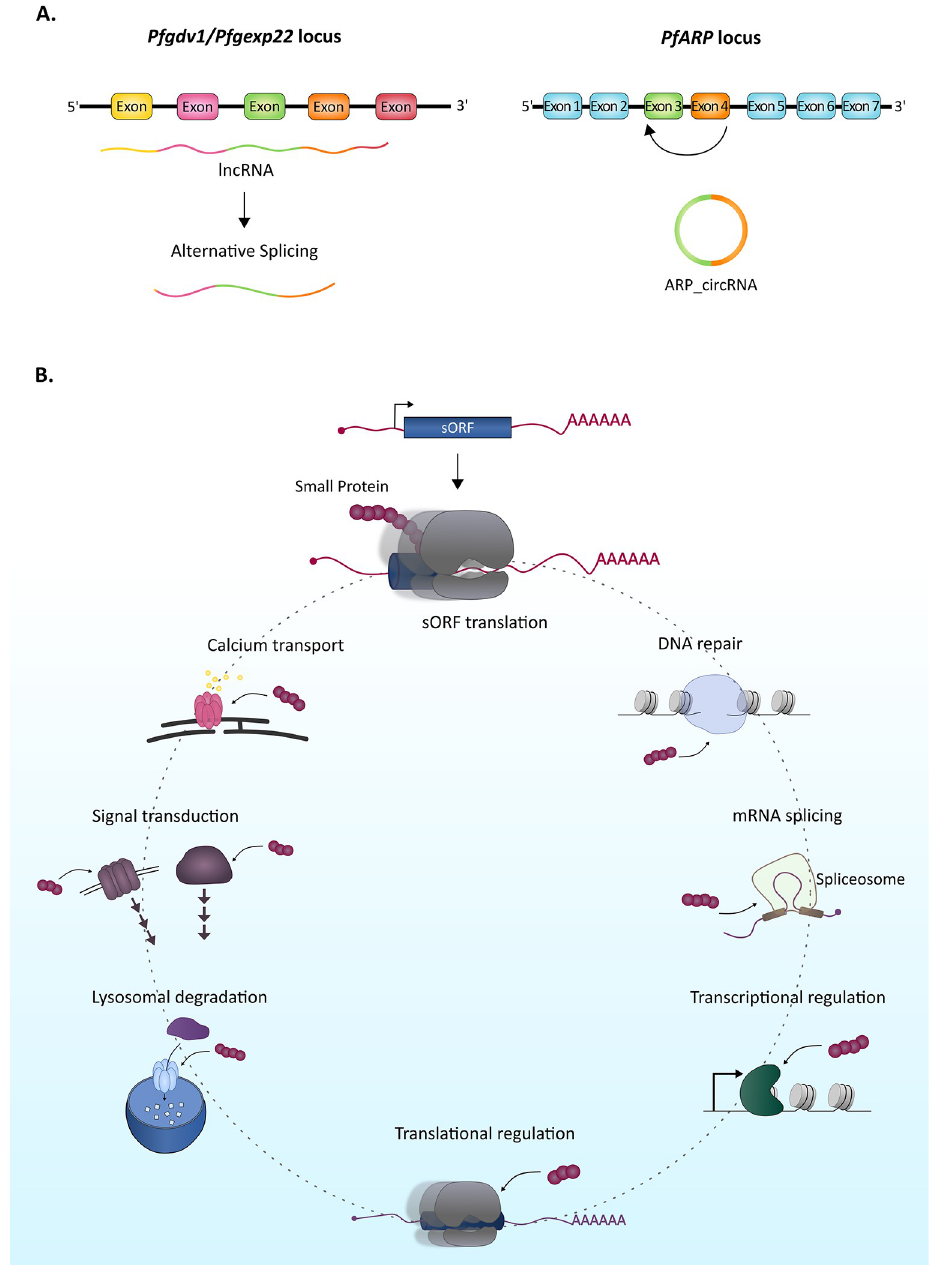
Fig 4. Splicing and translation of lncRNAs. (A) P . falciparum lncRNAs can undergo AS (left panel) and generate circRNAs as demonstrated for ARP_circRNA (apoptosis related protein circRNA) (right panel). (B) Some lncRNAs contain sORFs that are translated into small proteins with different biological roles, such as transcriptional and translational regulation, mRNA splicing, signal transduction, mitochondrial regulation, calcium transport, and lysosomal degradation. AS, alternative splicing; circRNA, circular RNA; lncRNA, long ncRNA; sORF, small open reading